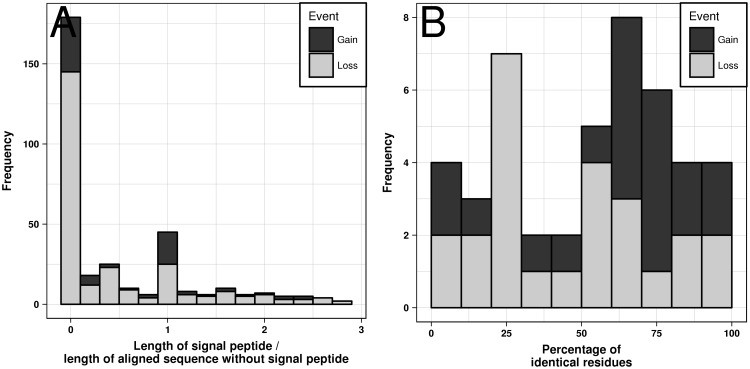
Comparison of signal peptide sequences and the aligned N-terminal sequences without a signal peptide. (A) Sequence length ratio. (B) Percentage of identical residues for those cases where the length ratio is between 0.9 and 1.1, that is, where both sequences have a comparable length.